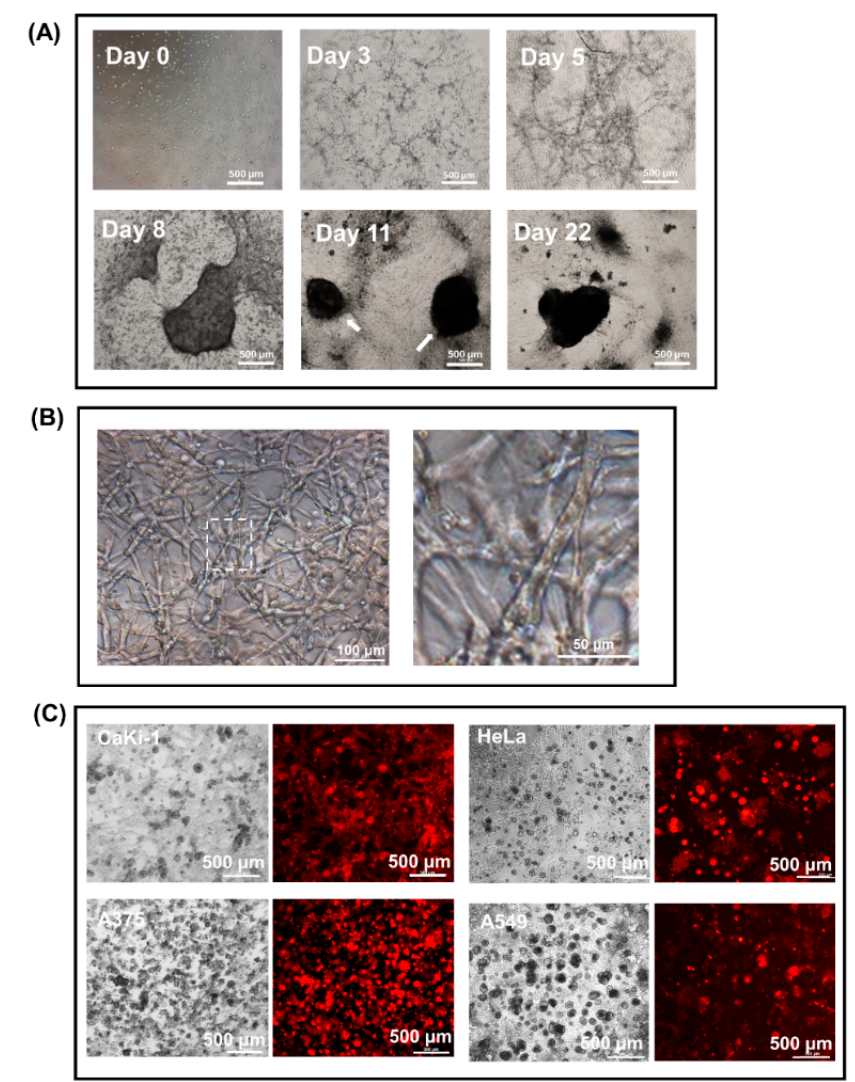
Figure 2. Consolidation of BHK-21 fibroblasts in Matrigel suspension into vessel-like structures and spheroid-like cell mass. ( A ) Time-lapse images showing BHK-21 vessel-like structures on days 0, 3, 5, 8, 11 and 22 that eventually morphed into a spheroid-like cell mass in a 50% Matrigel droplet. ( B ) Enlarged images of BHK-21 vessel-like structures. ( C ) Instead of developing into a network of vessel-like structures, cancer cells proliferate as small, independent colonies in 50% Matrigel suspension. Shown in the figure are CaKi-1 kidney carcinoma cells (12 days), HeLa cervical cancer cells (10 days), A375 human melanoma cells (7 days) and A549 lung adenocarcinoma cells (12 days) labelled with RFP after 7 to 12 days of culture as viewed under a fluorescent